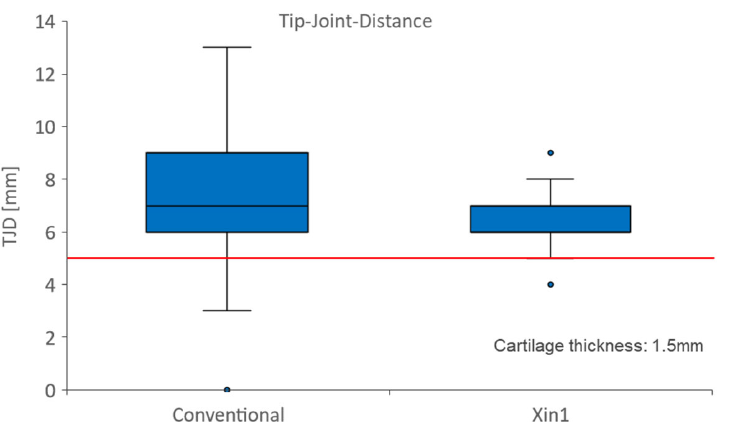
Figure 6. Precision of achieved tip–joint distance (TJD). Target distance was set to 5 mm in Xin1 (red line). In total, 48 screws were placed in 6 human specimens.